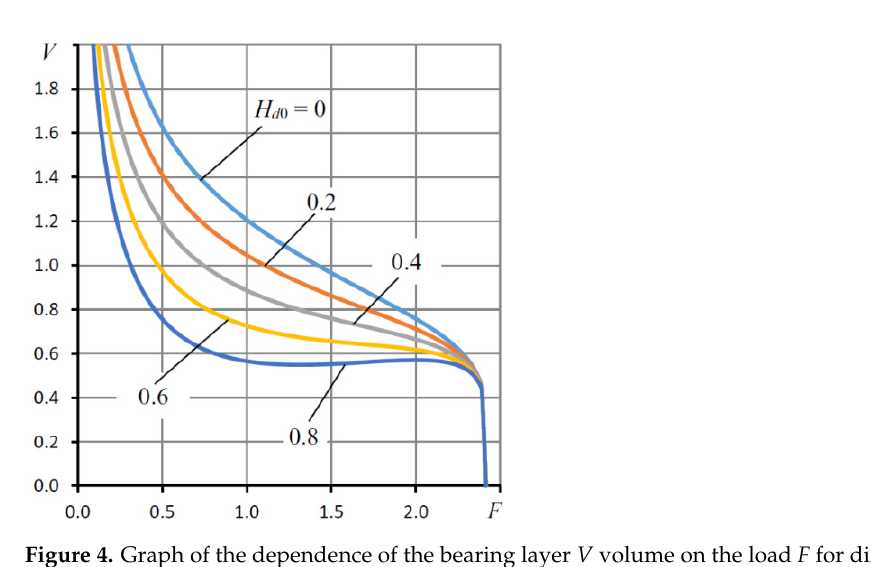
Figure 4. Graph of the dependence of the bearing layer V volume on the load F for different values of deformation H d 0 .